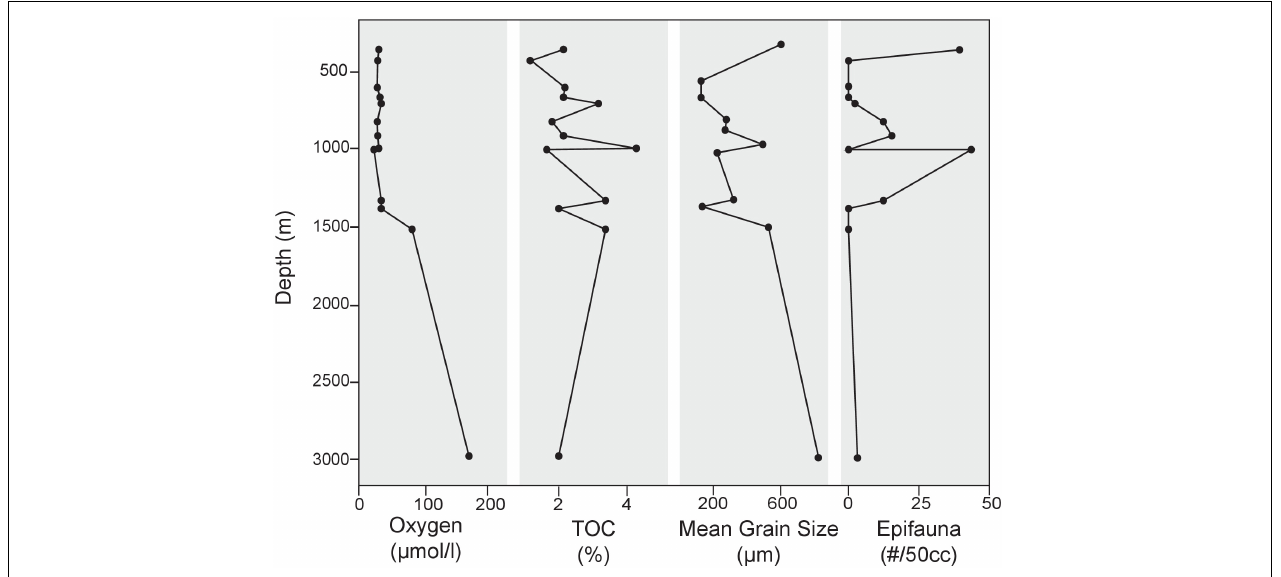
FIGURE 2 | Environmental and substrate parameters plotted along the depth transect along with standing stock of epifaunal foraminifera at each site. Mean grain size from particle size analysis lends insight to the heterogeneity of substrates sampled in this study. No apparent relationship between substrate and depth exists in this